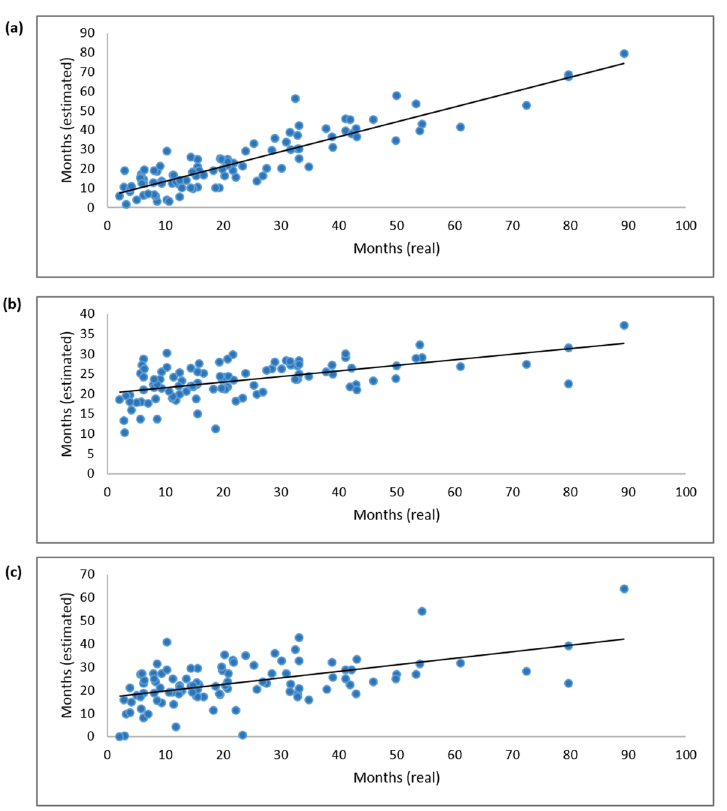
Figure 1. ( a) Prediction performance of SVR-LUAD with a correlation coefficient of 0.90. (b) Prediction performance of Elastic net with a correlation coefficient of 0.55. (c) Prediction performance of Multiple linear regression with a correlation coefficient of 0.53. X-axis refers to real survival time and Y-axis refers to estimated survival